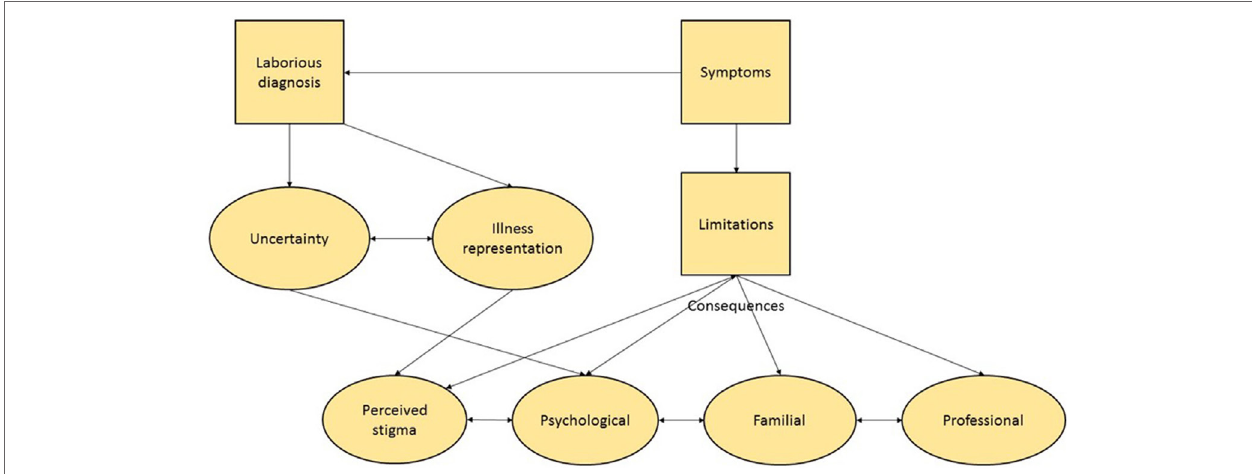
FigUre 3 | Grounded-theory model showing the impact of primary orthostatic tremor (POT) on daily life based on interviews. The flowchart was derived using a grounded-theory approach for the analysis of transcribed patient interviews. Two researchers with complementary profiles extracted the meaning of the patient’s spoken language by using a constant comparative method and grouping the data into themes and categories. Categories were subsequently organized to establish connections between the various codes, themes, and categories. The data which emerged illustrate the impact of POT on a patient’s everyday life. The directionality of the arrows demonstrates the interplay between each of these